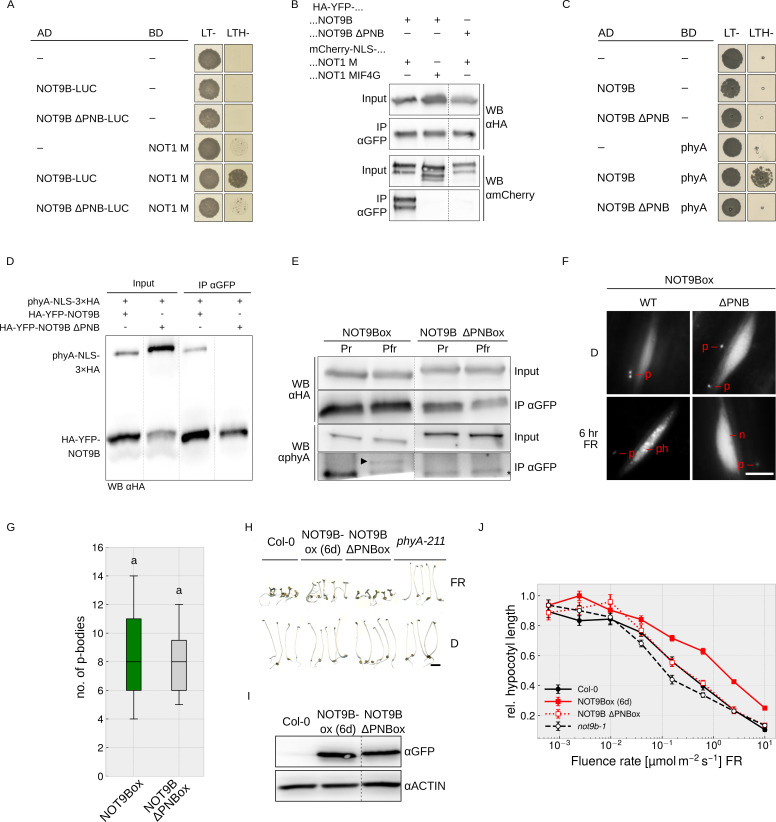
Both phyA and NOT1 bind to the PNB site of NOT9B.(A and C) Y2H growth assays. AH109 yeast cells were transformed with plasmids coding for the indicated AD and BD fusion proteins and grown on CSM LTH- plates containing 25 mM 3-AT (A) or grown in R light on CSM LTH- plates supplemented with 10 mM 3-AT and 20 μM phycocyanobilin (C). CSM LT- plates were used as transformation control. (B and D) CoIP from transiently transformed tobacco. Leaves of 4 week-old tobacco plants were co-infiltrated with Agrobacteria transformed with plasmids coding for p35S:HA-YFP-NOT9B or -NOT9B ΔPNB and p35S:FLAG-myc-mCherry-NLS-NOT1 M or -NOT1 MIF4G-mCherry (B), and p35S:PHYA-NLS-3×HA and either p35S:HA-YFP-NOT9B or -NOT9B ΔPNB (D). Plants were kept in the dark and exposed to W light for 5 min. Total soluble protein was then extracted and used for CoIP with αGFP magnetic beads. Input and eluate fractions were analysed by SDS-PAGE and immunoblotting with αHA and αmCherry (B) or αHA antibodies (D). (E) CoIP from transgenic Arabidopsis lines. Four-day-old dark-grown Arabidopsis seedlings expressing p35S:HA-YFP-NOT9B or -NOT9B ΔPNB were exposed to FR light for 5 hr followed by 5 min R (Pfr) or long-wavelength FR light (Pr). Total soluble protein was then extracted and used for CoIP with αGFP magnetic beads. Input and eluate fractions were analysed by SDS-PAGE and immunoblotting with αHA and αphyA antibodies. *, unspecific band; ►, phyA. (F) Nuclear body formation of NOT9B and NOT9B ΔPNB. Four-day-old dark-grown Arabidopsis seedlings expressing p35S:HA-YFP-NOT9B (NOT9Box WT, line 6d) or -NOT9B ΔPNB (NOT9Box ΔPNB) were exposed to FR light for 6 hr or kept in the dark and analysed by epifluorescence microscopy. Scale bar represents 5 μm. p, p-body; ph, photobody; n, nucleus. (G) Quantification of p-bodies. Seedlings expressing p35S:HA-YFP-NOT9B (NOT9Box) or p35S:HA-YFP-NOT9B ΔPNB (NOT9B ΔPNBox) were grown for 4 days in D. Pictures were taken and number of p-bodies was counted in a 200 × 350 pixel area. Boxplots represent 12 evaluated areas per line. Letters indicate levels of significance as determined by one-way ANOVA followed by post-hoc Tukeys HSD test; p<0.05. (H) Phenotype of NOT9B ΔPNBox seedlings. Seedlings were grown for 4 days in FR light (FR, 40 μmol m−2 s−1) or in the dark. Scale bar represents 2 mm. (I) Western blot analysis of protein levels. Total protein was extracted from 4-day-old dark-grown Arabidopsis seedlings expressing p35S:HA-YFP-NOT9B (NOT9Box, line 6d) or -NOT9B ΔPNB (NOT9B ΔPNBox) and analysed by SDS-PAGE and immunoblotting with αGFP and αACTIN antibodies. ACTIN was detected as loading control. (J) Fluence rate response curve for inhibition of hypocotyl growth. Arabidopsis seedlings expressing p35S:HA-YFP-NOT9B (NOT9Box, line 6d) or -NOT9B ΔPNB (NOT9B ΔPNBox) were grown for 4 days in FR light. Mean hypocotyl length (±SE) of 20 seedlings relative to dark-grown seedlings is shown.